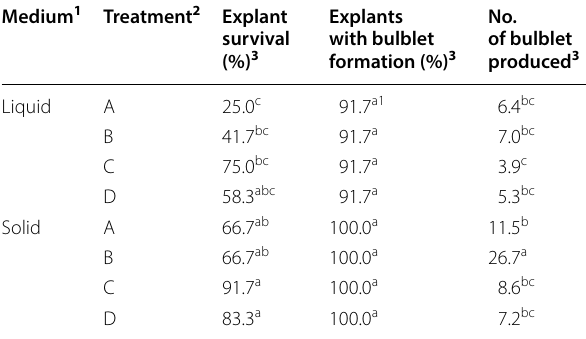
Table 4 Effects of different sections/incisions and solid and liquid medium on bulblet regeneration in F. cirrhosa